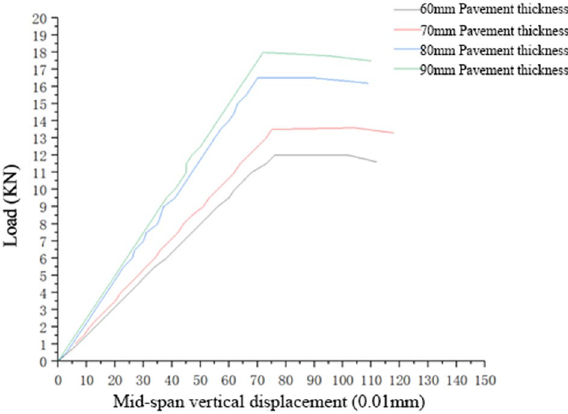
Figure 6. Load–displacement curve of a single-layer pavement structure with different pavement thicknesses under the simulated action of a negative bending moment.